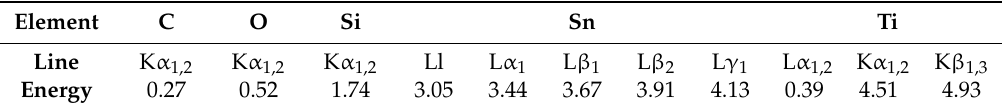
Table 1. Characteristic lines received from the EDS spectrum of the TiO 2 / FTO / glass stack with energies in keV.